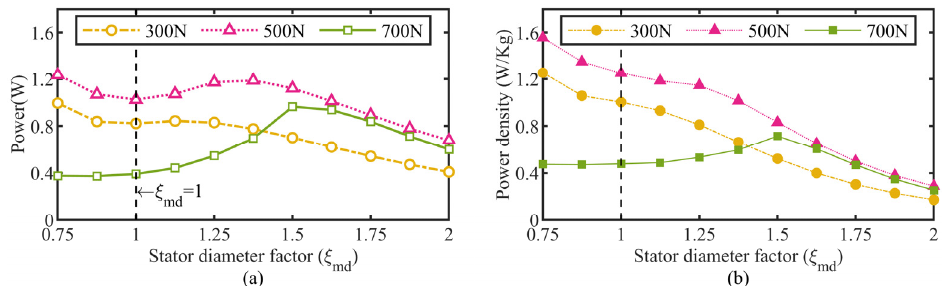
Figure 15. HUSM stator diameter’s effect on actuator performance. ( a ) Power and ( b ) power density versus stator diameter factor.